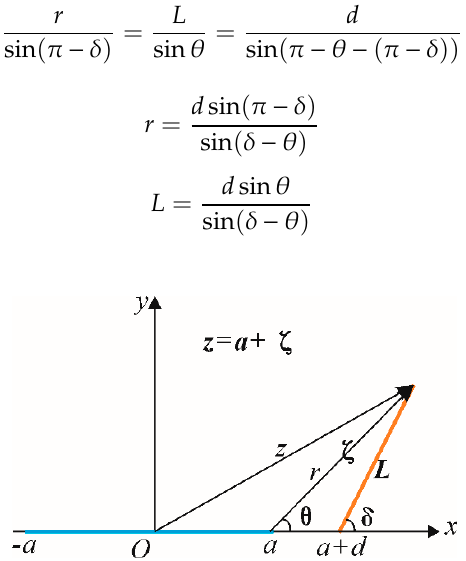
Figure 10. Polar coordinate system of fracture front of nonorthogonal joint.